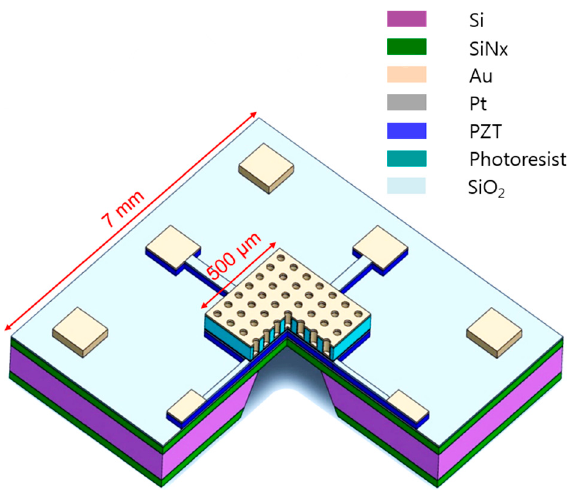
Figure 1. A schematic diagram of the pyroelectric IR detector with a plasmonic crystal structure. The cross-sectional part shows the micro membrane structure of the detector.